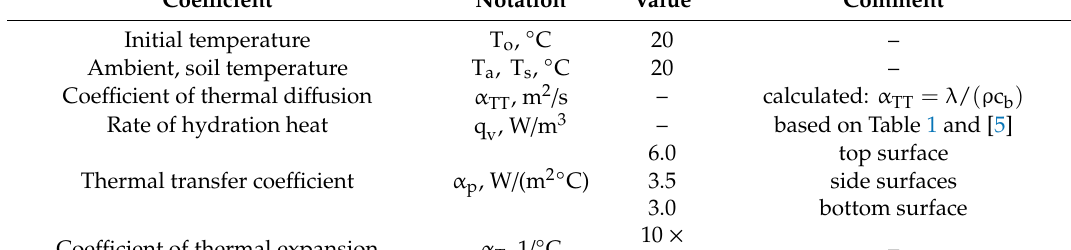
Table 9. Thermo–mechanical properties of concretes used in the FE analysis and analytical calculation.